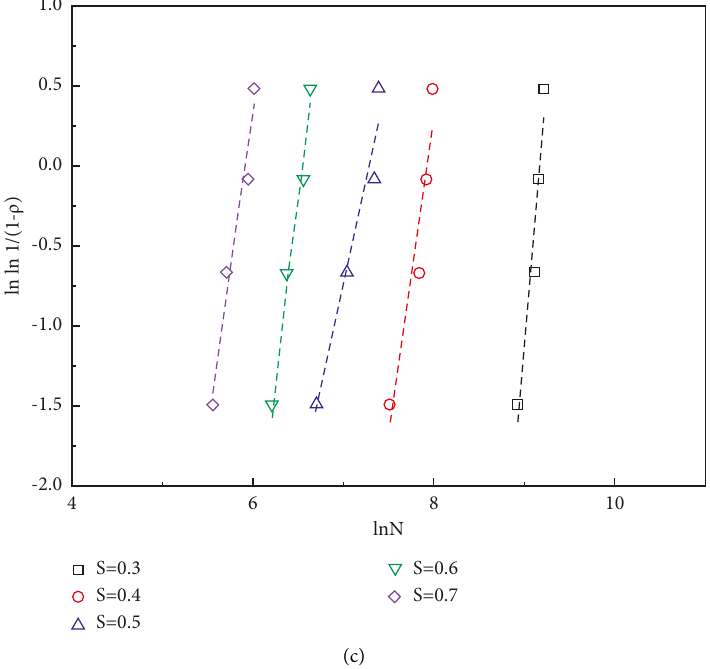
Figure 6: Weibull fitting results of the SMA-13 mixture with specification gradation. (a) Marshall method. (b) SGC method. (c) VTM